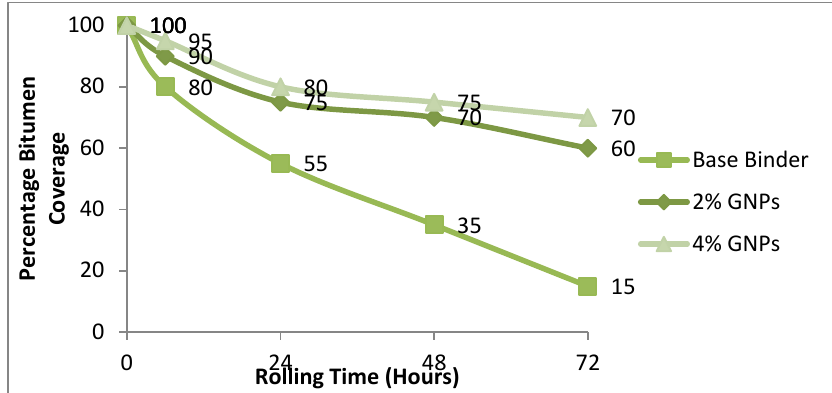
Appl. Sci. 2019 , 9 , x FOR PEER REVIEW Figure 12. The Rolling Time vs the Percentage of Bitumen Coverage. GNPs = Graphene Nano-Platelets.